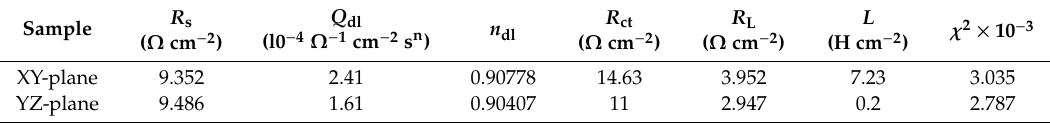
Table 3. Parameters of the EC model obtained from simulations based on the EIS experimental data.